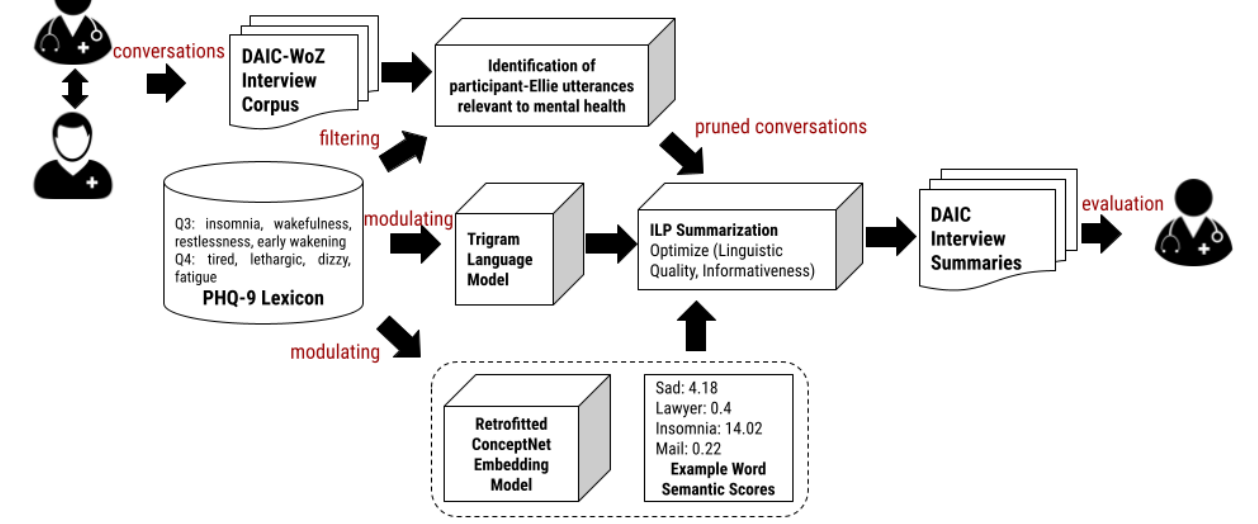
Figure 2. The overall workflow of our proposed model to generate contextual summaries of clinical diagnostic interviews. First, a PHQ-9 lexicon filters out irrelevant occurrences. Next, the ConceptNet embedding model was modulated using PHQ-9 Lexicon using a retrofitting procedure. The improved model was used to generate Word Semantic Scores. These scores quantify the importance of words in a conversation piece. A unified ILP framework of pruned conversations, trigram language model, and WSS, generates abstractive summaries. Q3 and Q4 in PHQ-9 Lexicon are questions in the PHQ-9 questionnaire. So, our Lexicon has nine categories associated with nine items in the questionnaire. DAIC-WoZ: Distress Analysis